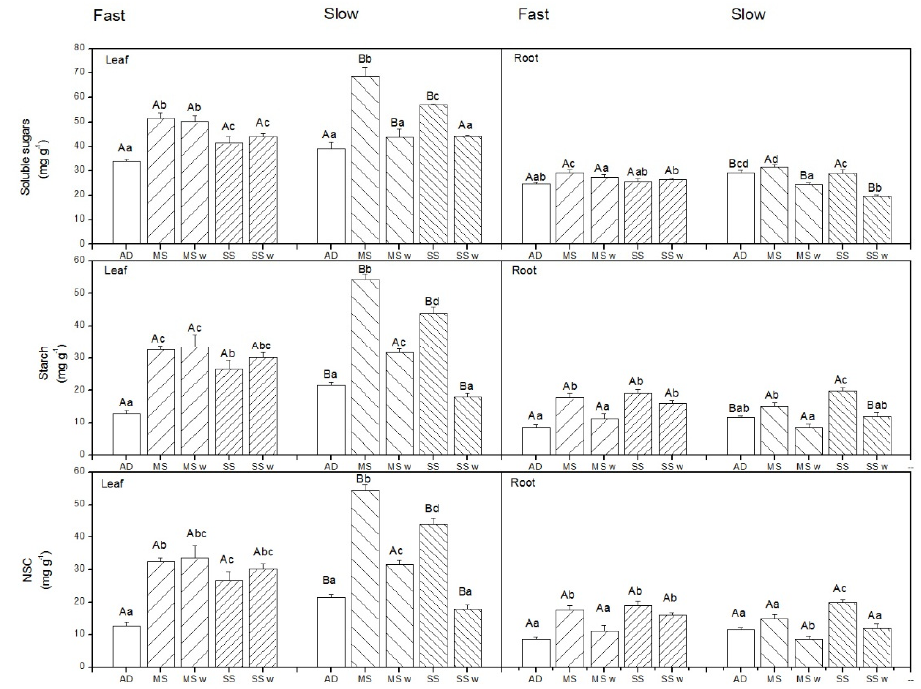
Figure 3. Concentrations of soluble sugars, starch and nonstructural carbohydrate (NSC) in roots and leaves of the two genotypes (I-101 ( Populus alba L.) × 84K ( Populus alba L. × Populus glandulosa Uyeki)) were taken at the end of the drought and watering. The five pillars on the left of each panel represent the fast group, and those on the right represents the slow group. Letters indicate significant differences ( p < 0.05) for a given species and treatment, including AD (control, absence of drought), MS (moderately water-stressed), SS (severely water-stressed), MS rewater (moderately water-stressed plants that were rewatered after drought) and SS rewater (severely water-stressed plants that were rewatered after drought); lowercase is used for single genotype between different sets, and uppercase is used for two genotypes between the same treatment.